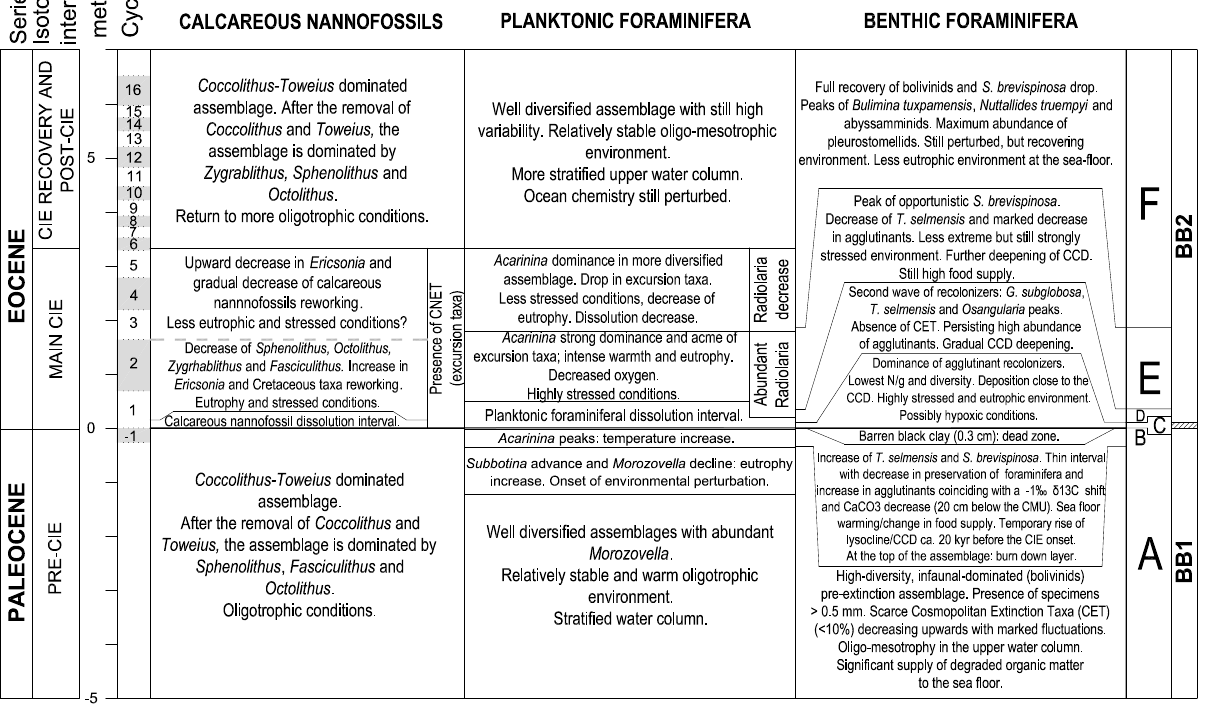
Figure 8. Summary of main calcareous plankton (calcareous nannofossils and planktonic foraminifera) and benthic foraminiferal events and inferred environmental conditions (from Agnini et al., 2007; Luciani et al., 2007 and present work), isotopic intervals, thickness, precessional cycles and benthic foraminiferal assemblages (A to F) recognized in this work. The stratigraphic intervals containing assemblages A and B, C, and D to F are considered as pre-extinction, extinction and repopulation intervals, respectively. Benthic foraminiferal zonation after Berggren and Miller (1989). CNET: calcareous nannofossil excursion taxa (see Agnini et al.,